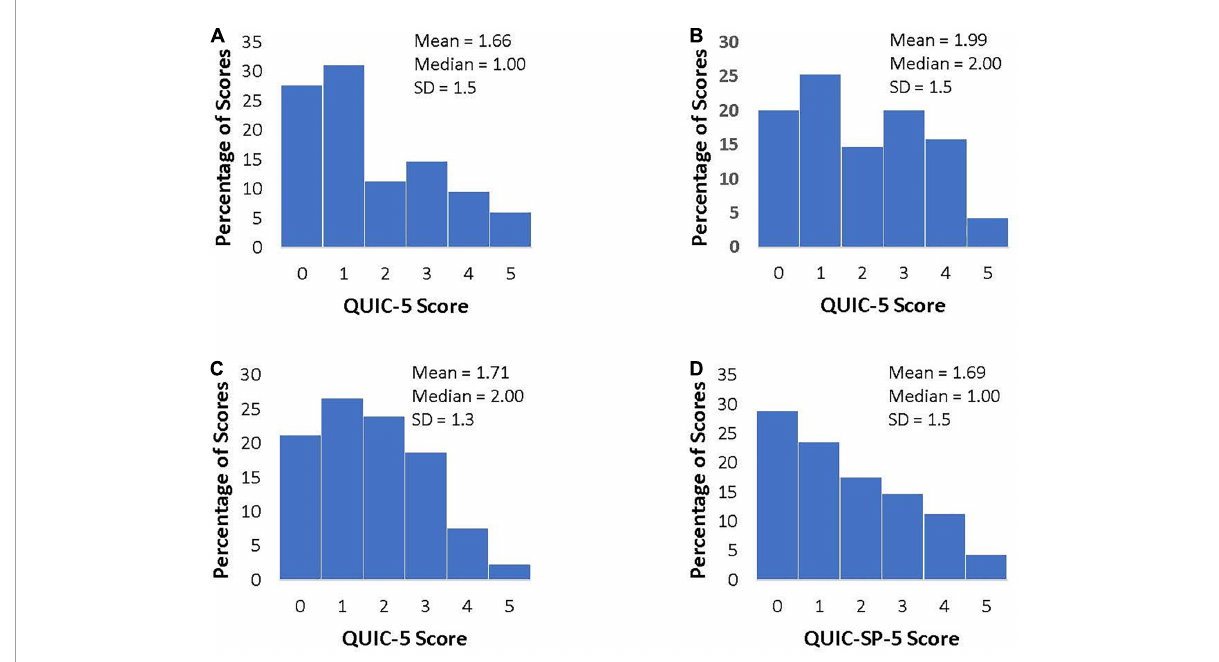
FIGURE1 Distributions of QUIC-5 and QUIC-SP-5 Scores. (A) Adult females ( N = 116), (B) male veterans ( N = 95), (C) adolescents ( N = 226), and (D) Spanish-speaking adults ( N = 285).